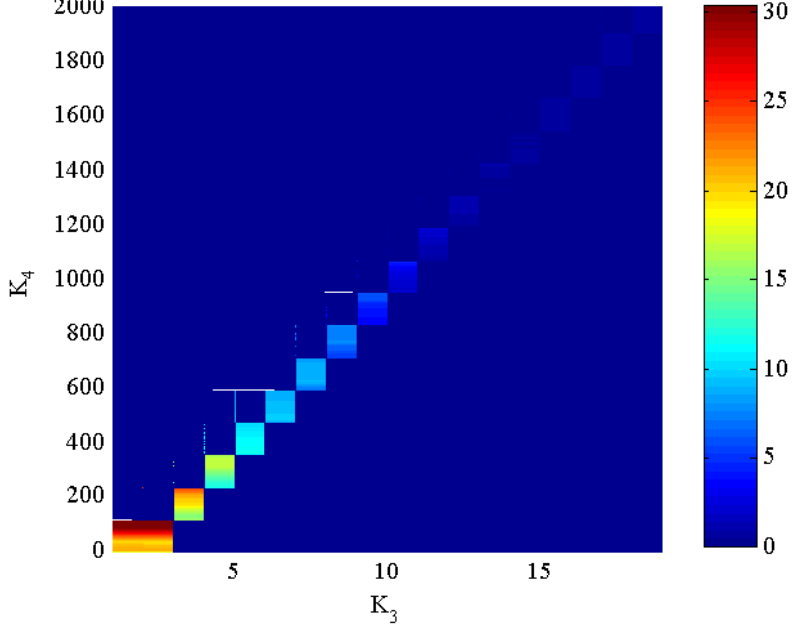
Figure 5. Impact of the fitness function J q parameters on the Γ rip